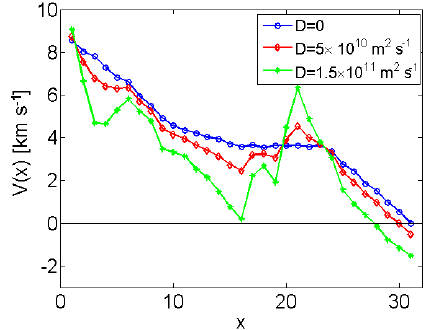
Figure 14. Velocity profiles assuming different levels of constant